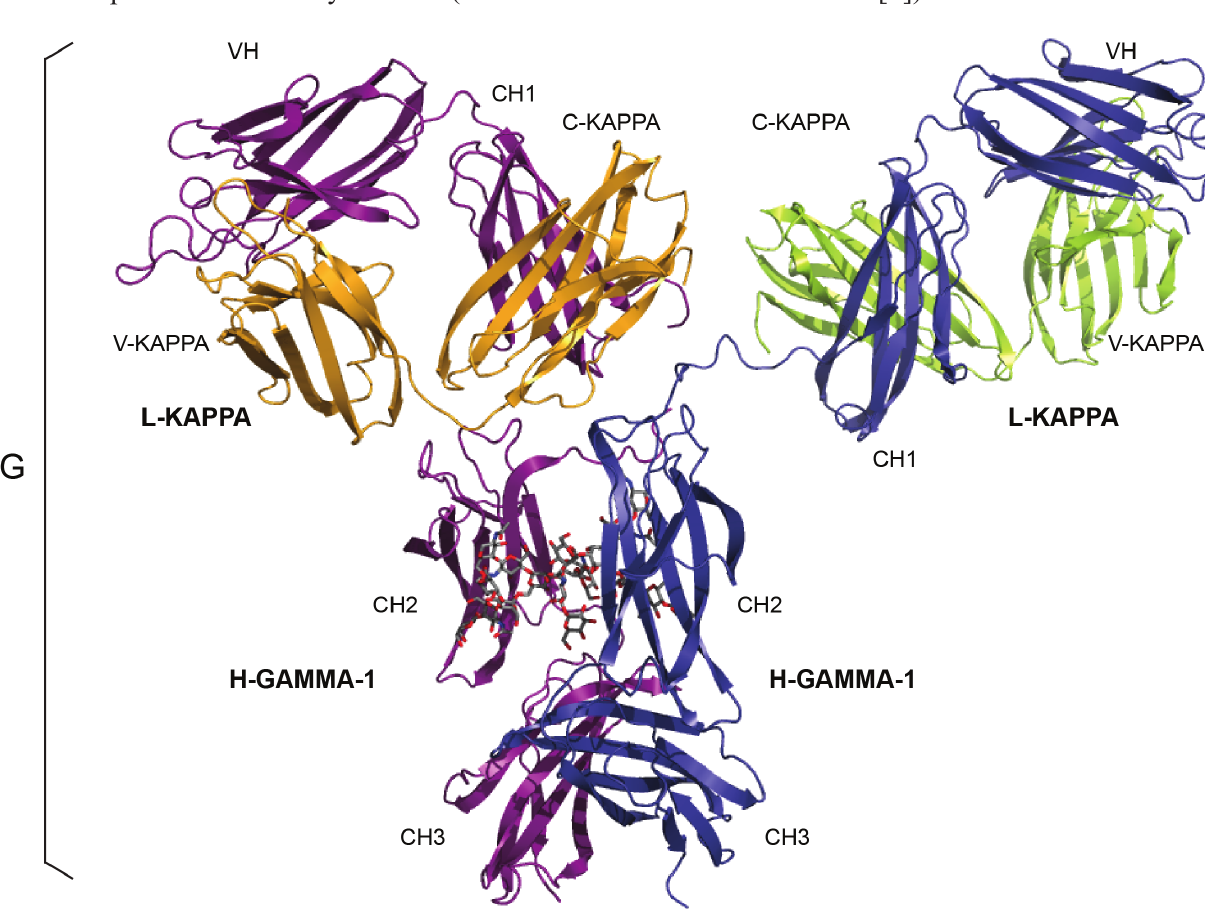
other labels are characteristics of the V-DOMAIN and correspond to the first amino acid of the canonical F/W-G-X-G motif (where F is phenylalanine, W tryptophan, G glycine, and X any amino acid) encoded by the J-REGION: J-PHE or J-TRP (F or W at position 118) [60–62,65]. Figure 2. An immunoglobulin (IG) or antibody. In vivo , an IG or antibody is anchored in the membrane of a B cell as part of a signaling B cell receptor (BcR = membrane IG + CD79) or, as shown here, is secreted [3]. An IG is made of two identical heavy (H, for IG-HEAVY) chains and two identical light (L, for IG-LIGHT) chains [3]. An IG comprises 12 domains (for example, IgG1, shown here) or 14 domains (IgM or IgE). The V-DOMAIN of each chain (green online) and the C-DOMAIN, one for each L chain and three for each H chain (blue online) are highlighted. The light chain (here, L-KAPPA) is made of a variable domain (V-DOMAIN, here, V-KAPPA) at the N-terminal end and a constant domain (C-DOMAIN, here, C-KAPPA) at the C-terminal end. The heavy chain (here, H-GAMMA-1) is made of a VH (at the N-terminal end) and of three CH (four for H-MU or H-EPSILON) (Table 1) [3]. The structure is that of the antibody b12, an IgG1-kappa, and so far the